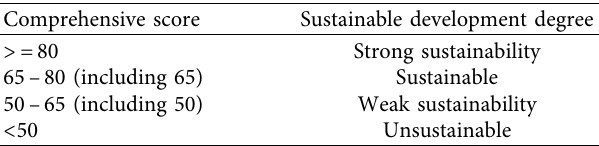
Table 1: Classification of evaluation criteria for sustainable